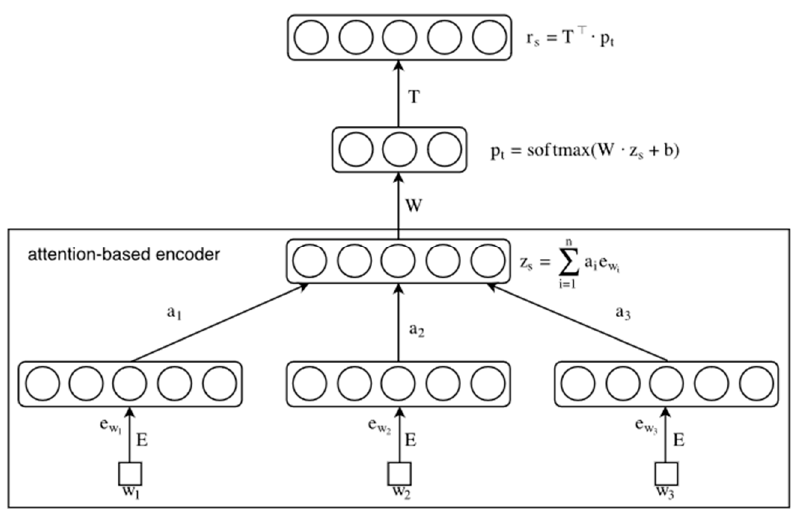
Figure 3. Attention-Based Aspect Extraction model